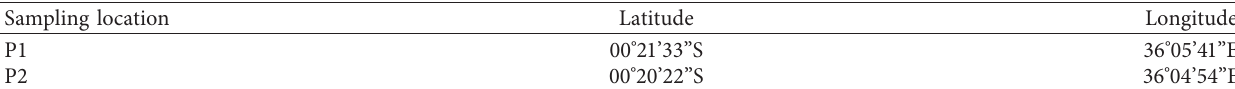
Table 1: Sediment core sampling